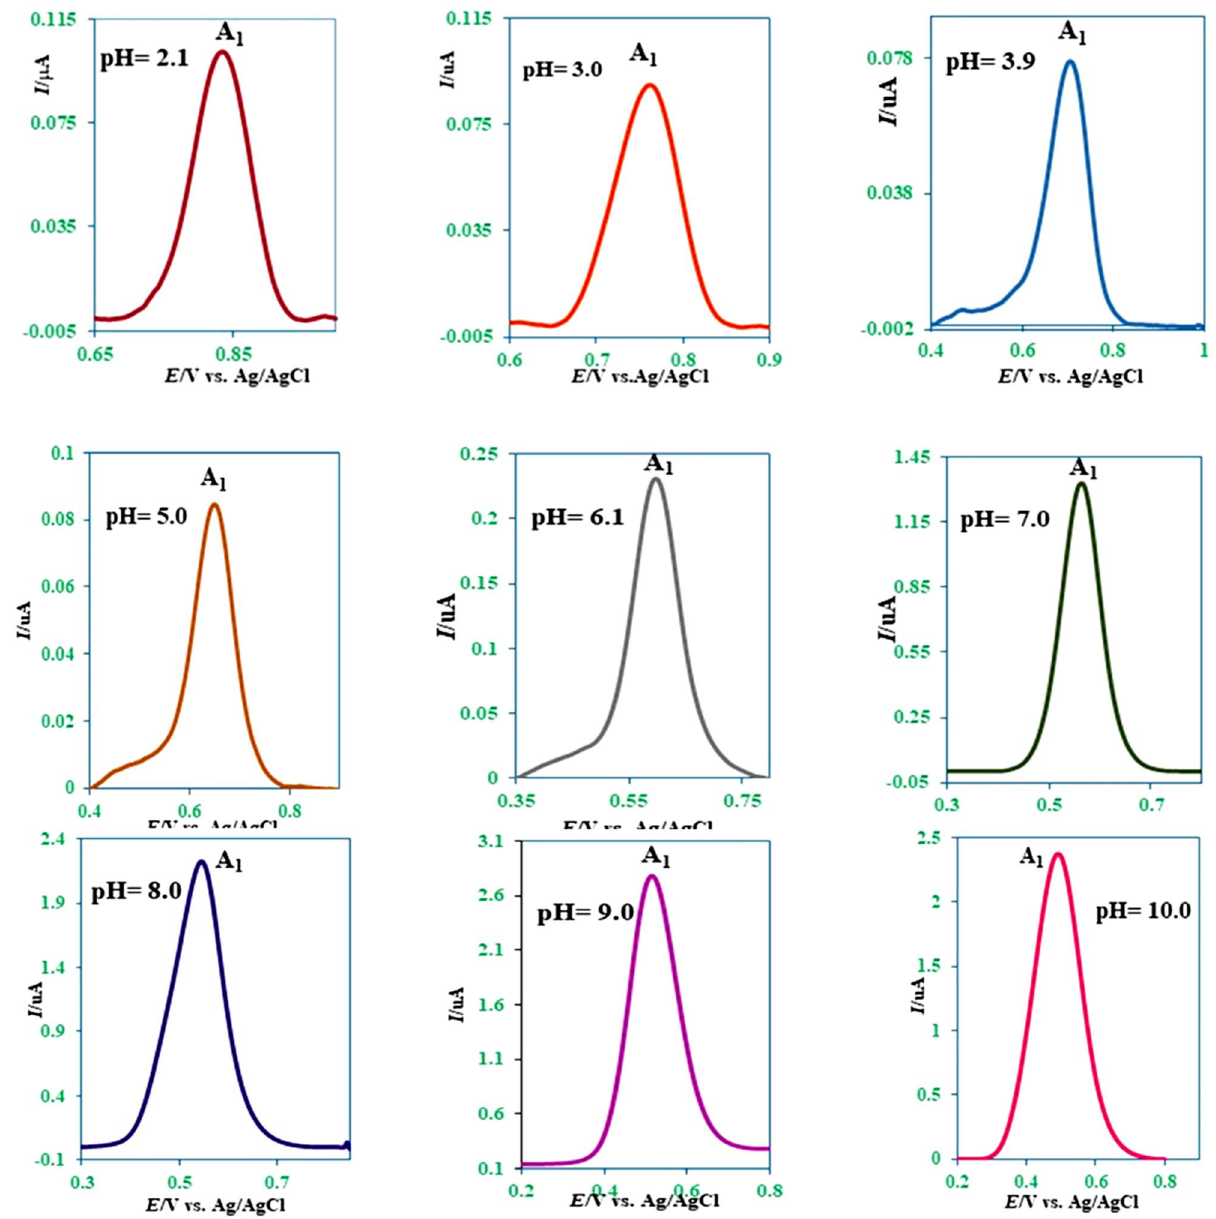
Figure 2. Differential pulse voltammograms of mefenamic acid ( MFA ) (0.4 mM) at the surface of glassy carbon electrode in buffered solutions with various pH s and same ionic strength (c = 0.2 M). Potential scan rate: 10 mV/s. Room